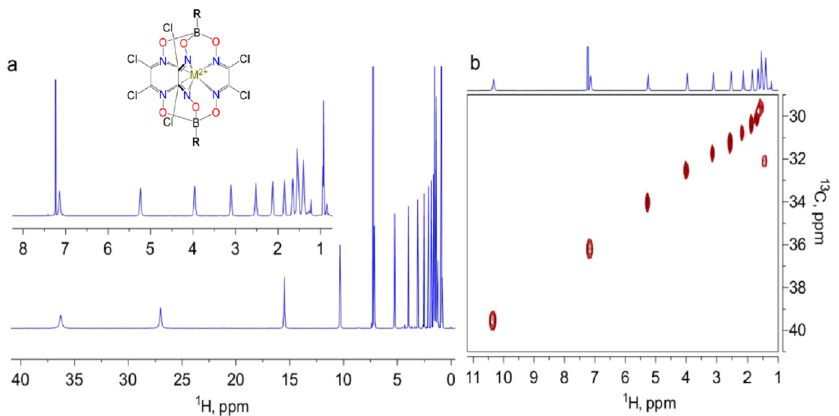
Figure 8. 1 H ( a ) and fragment of 1 H- 13 C Heteronuclear Single Quantum Coherence ( b ) NMR spectra (600 MHz, 298 K, 5 mM in solution CDCl 3 ) of the Co(II) complex shown in the inset (M 2+ = Co 2+ , R = n -C 16 -H 33 ). The sharp signal at 7.25 ppm corresponds to the residual signal of the solvent. Reprinted with permission from ref. [95], copyright 2014 American Chemical Society.